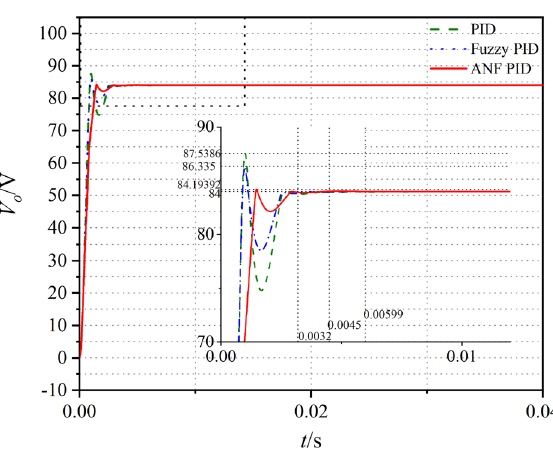
Figure 13. Simulation model of closed-loop system.